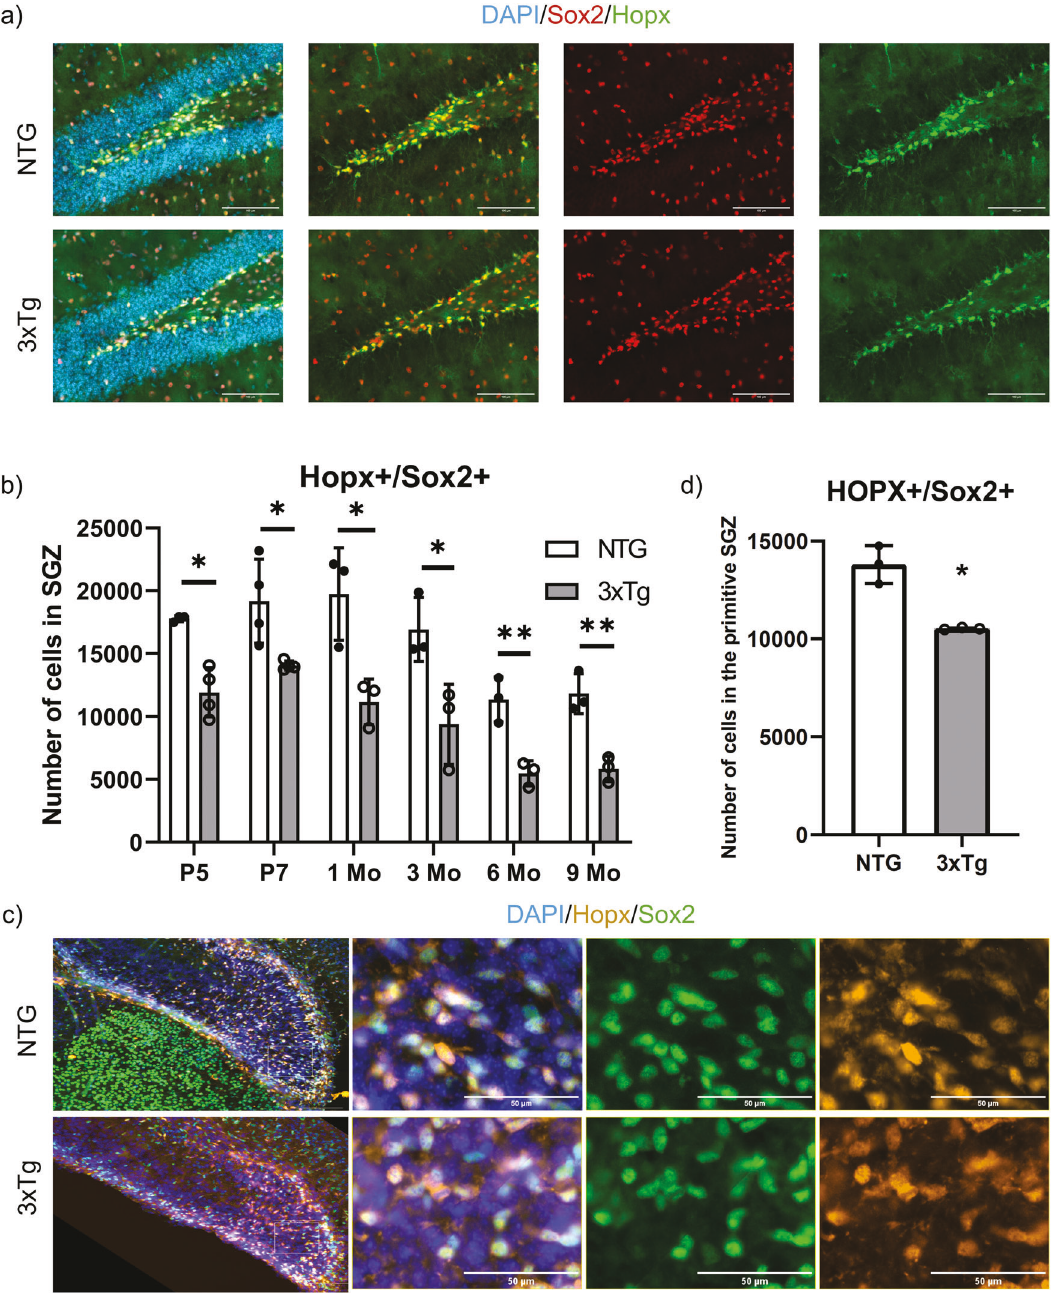
Fig. 3 Decline in the Hopx-expressing population in the SGZ of 3xTg mice at as early as postnatal days. a Representative fl uorescent images of Hopx (in green) and Sox2 (in red) at 1 month of age in coronal section of NTG (Top) and 3xTg (Bottom). GCL is visualized by DAPI. Scale bar 100 µm . b Quanti fi cation of the total number of Hopx-positive/Sox2-positive cells in the SGZ at postnatal day 5 (P5); postnatal day 7 (P7); 1 month of age (1Mo); 3 months of age (3Mo); 6 months of age (6Mo) and 9 months of age (9Mo). c Representative fl uorescent images of Hopx (in yellow), Sox2 (in green) and DAPI (Blue) at postnatal day 0 in coronal section of NTG (Top) and 3xTg (Bottom). Scale bar 100 µm. Magni fi ed view of fl uorescent images were shown for merged, Sox2 and Hopx on the left. d Quanti fi cation of the total number of Hopx- positive/Sox2-positive cells in the primitive structure of the dentate gyrus at postnatal day 0. Data represented as mean ± SD. A two-tailed, unpaired Student ’ s t -test was used for statistical analysis ( p < 0.05*, p < 0.01**), n = 4 for P5 and P7; n = 3 for P0, 1Mo, 3Mo, 6Mo and phenotype in the 3xTg model starts before the extracellular A β The results of this study support the hypothesis that defects in neurogenesis in the 3xTg model of AD occur early and precede the onset of AD pathology. When compared to NTG controls, 3xTg mice presented with a smaller volume of GCL, DG and hippocampus at both P7 and 3 months old (Fig. 1). This structural